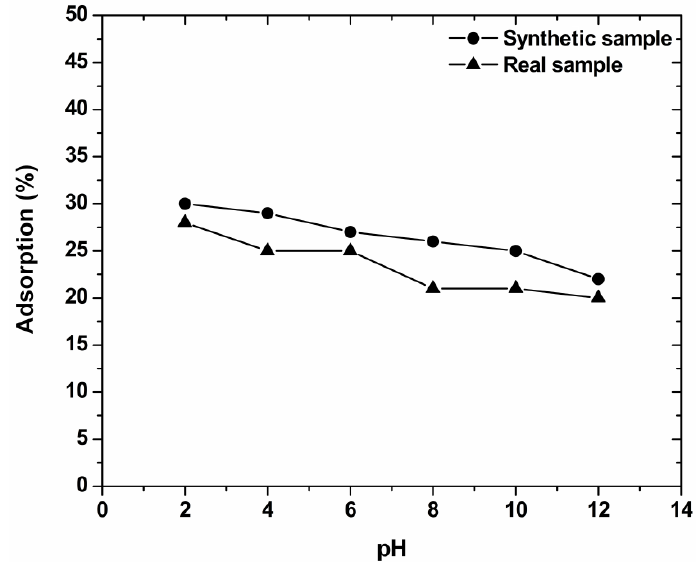
Figure 4. Effect of pH on decolorization of real and synthetic dyeing solutions with COF (pH = 2–12; 1 g/L adsorbent; 700 mg/L total dye concentration; T = 25 °C; 140 rpm; 24 h